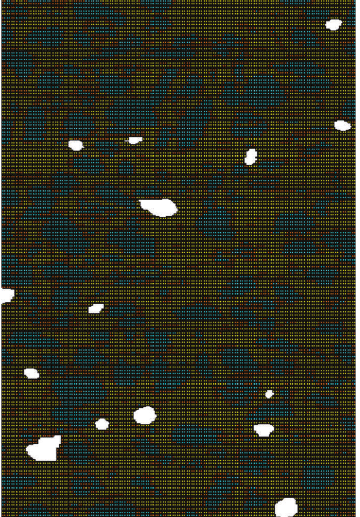
Figure 11: Whole reconstruction model.